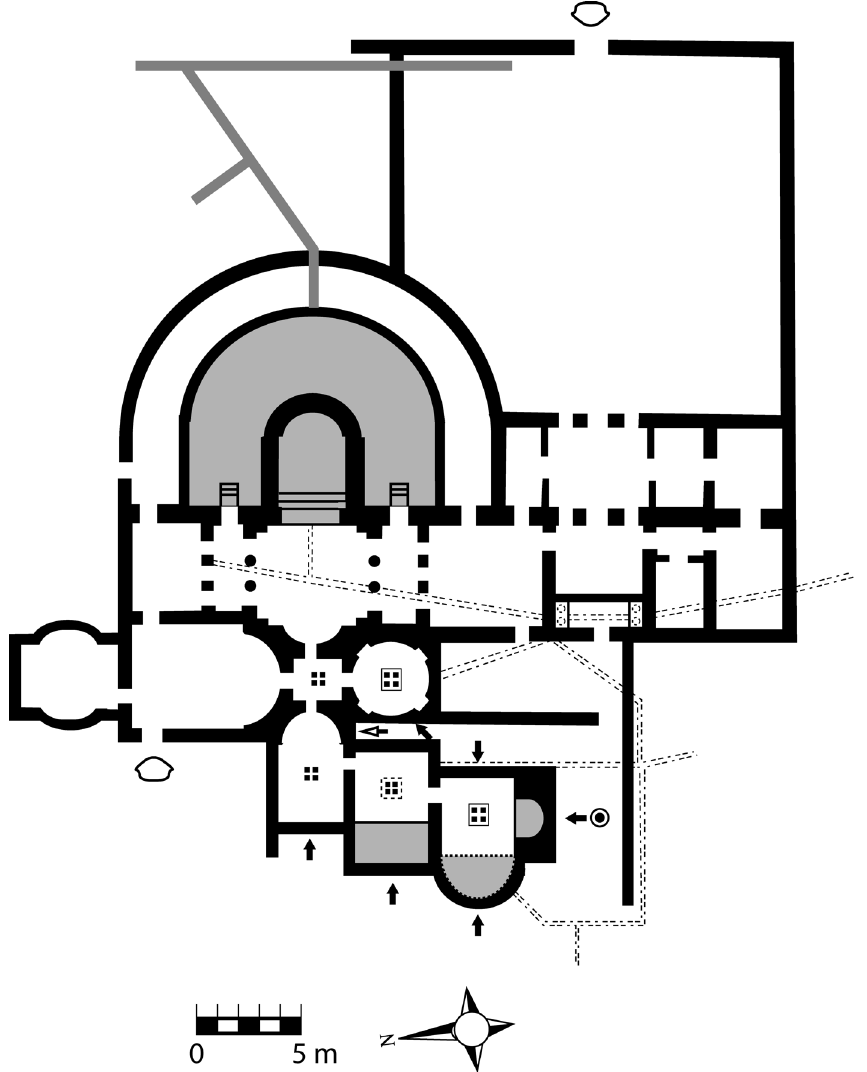
Figure 6: The baths at Oued Athmenia (after Poulle 1878: pl.